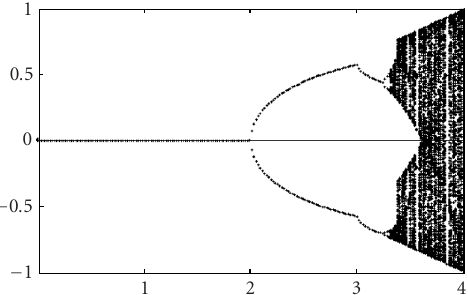
Figure 3.1. The bifurcation diagram of the iterated map Z n +1 = aZ 3 n + (1 − a ) Z n over 0 < a < 4 ob- tained from Z 0 = Z + .